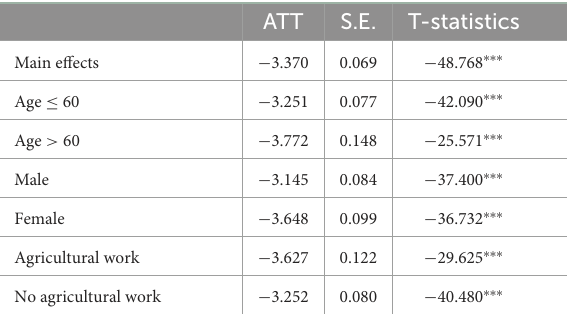
TABLE 8 The effect of internet use on depression using the endogenous switching regression (ESR)